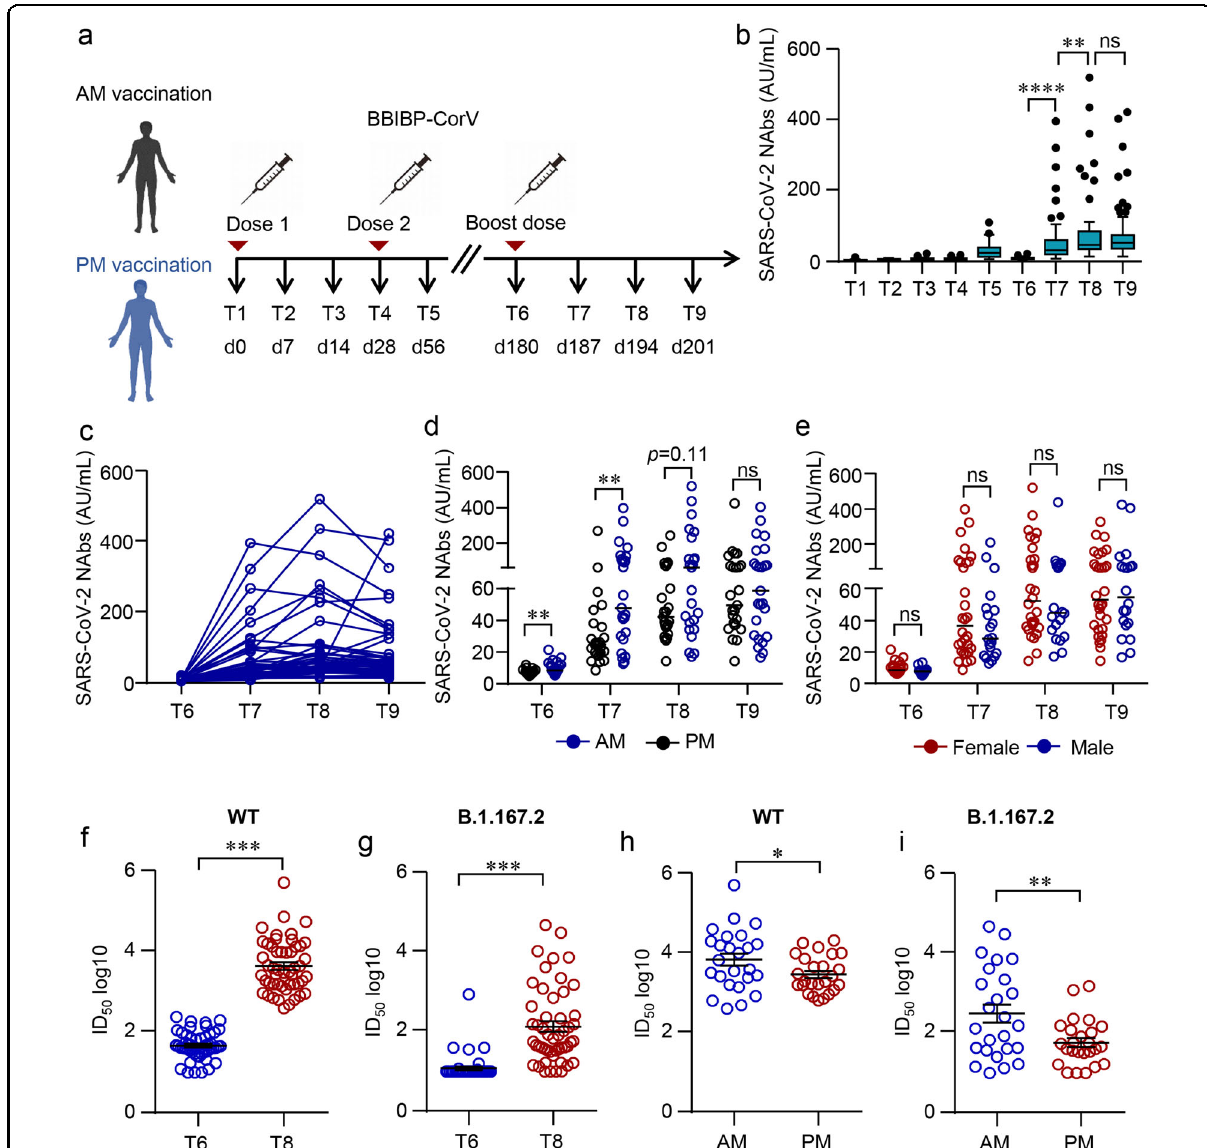
Fig. 1 Humoral responses induced by a third dose of inactivated SARS-CoV-2 vaccine BBIBP-CorV. a Protocol of the prospective cohort and the nonrandomized trial. Healthcare workers (HCWs) were recruited from a perspective cohort who received two doses of an inactivated vaccine either in the morning (AM, n = 25) or afternoon (PM, n = 25) on day (d) 0 and d28. They were assigned to morning or afternoon vaccination to receive a third dose of the inactivated vaccine on day 180 according to their previous vaccinating time. Blood samples were collected on different time points d0 (T1), d14 (T2), d21 (T3), d28 (T4), d56 (T5), d180 (T6), d187 (T7), d194 (T8), and d208 (T9). b – e Neutralizing antibodies (NAbs) against SARS-CoV-2 in the serum of each volunteer was measured by Chemi fl uorescence Assay longitudinally. b The concentration of NAbs in the sera at different time points was summarized and shown in the box plot. c The longitudinal changes of NAbs in the sera before and after the third dose of vaccination. d NAbs in the sera from the morning or afternoon group at different time points. e NAb concentrations in the sera of female or male. Medians of the data were shown. f , g Neutralizing activities of sera against SARS-CoV-2 were measured by pseudovirus neutralizing assay. Half- maximal inhibitory dilutions (ID 50 ) of sera from T6 and T8 against SARS-CoV-2 WT and Delta variant (B.1.167.2) were summarized. h , i Comparison of neutralizing activities between the morning and afternoon group on T8. Comparisons were done by Wilcoxon rank-sum test in b – e or Student ’ s t - test in f – h . ** P < 0.01, **** P < 0.0001; ns, not signi fi